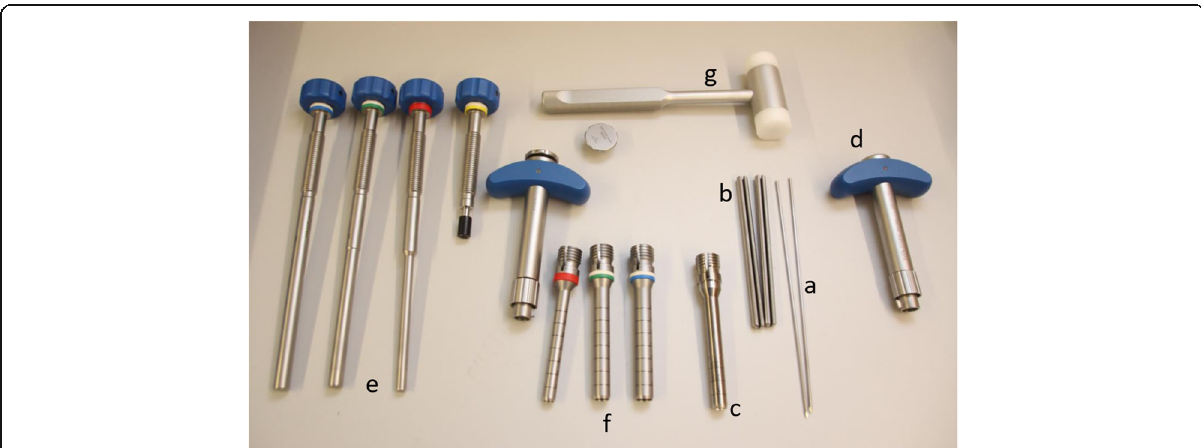
Fig. 1 The complete selection of instruments for the autologous transplantation of a bone cylinder. a Guidewire, b novel centering device for the bone harvester, c novel, modified bone harvester with centering fins with an inner diameter of 10 mm, d handle, e harvested bone remover, f bone harvester with an inner diameter of 10, 12, 14 mm, g